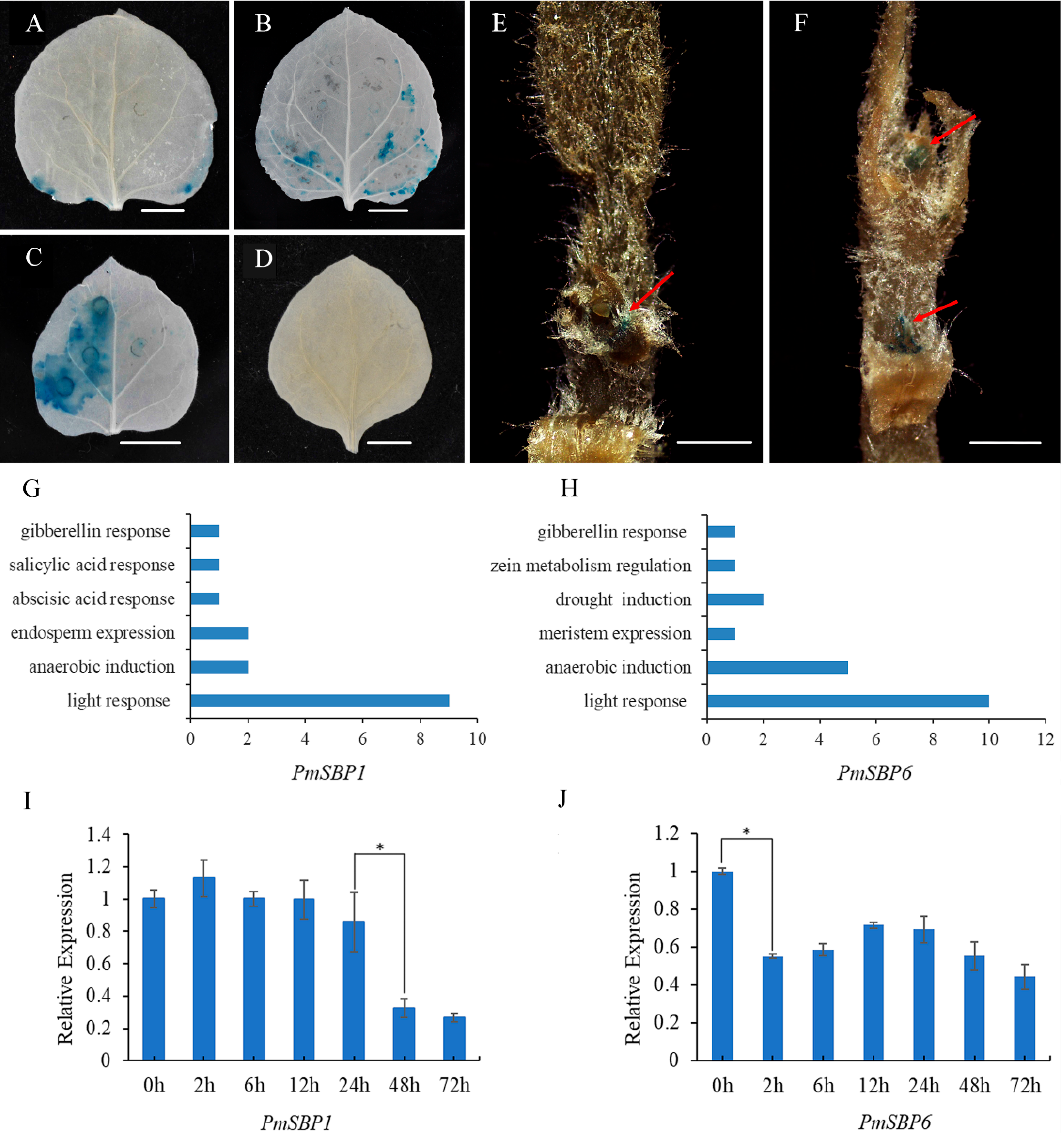
Figure 2. Analysis of the PmSBP1 / 6 promoter function and their response to GA3. ( A , B ) The activity of the PmSBP1 / 6 promoters. ( C ) The 35S::GUS positive control. ( D )The negative control without any vector. The scale bar in ( A – D ) is 1 cm. ( E , F ) The spatial expression profile of PmSBP1 / 6 . The red arrows indicate the location of GUS staining. The scale bar is 1 mm. ( G , H ). The promoter cis -elements composition of PmSBP1 / 6 . ( I , J ) The expression of PmSBP1 / 6 under GA3 treatment. The asterisk indicates significant differences ( p < 0.01).